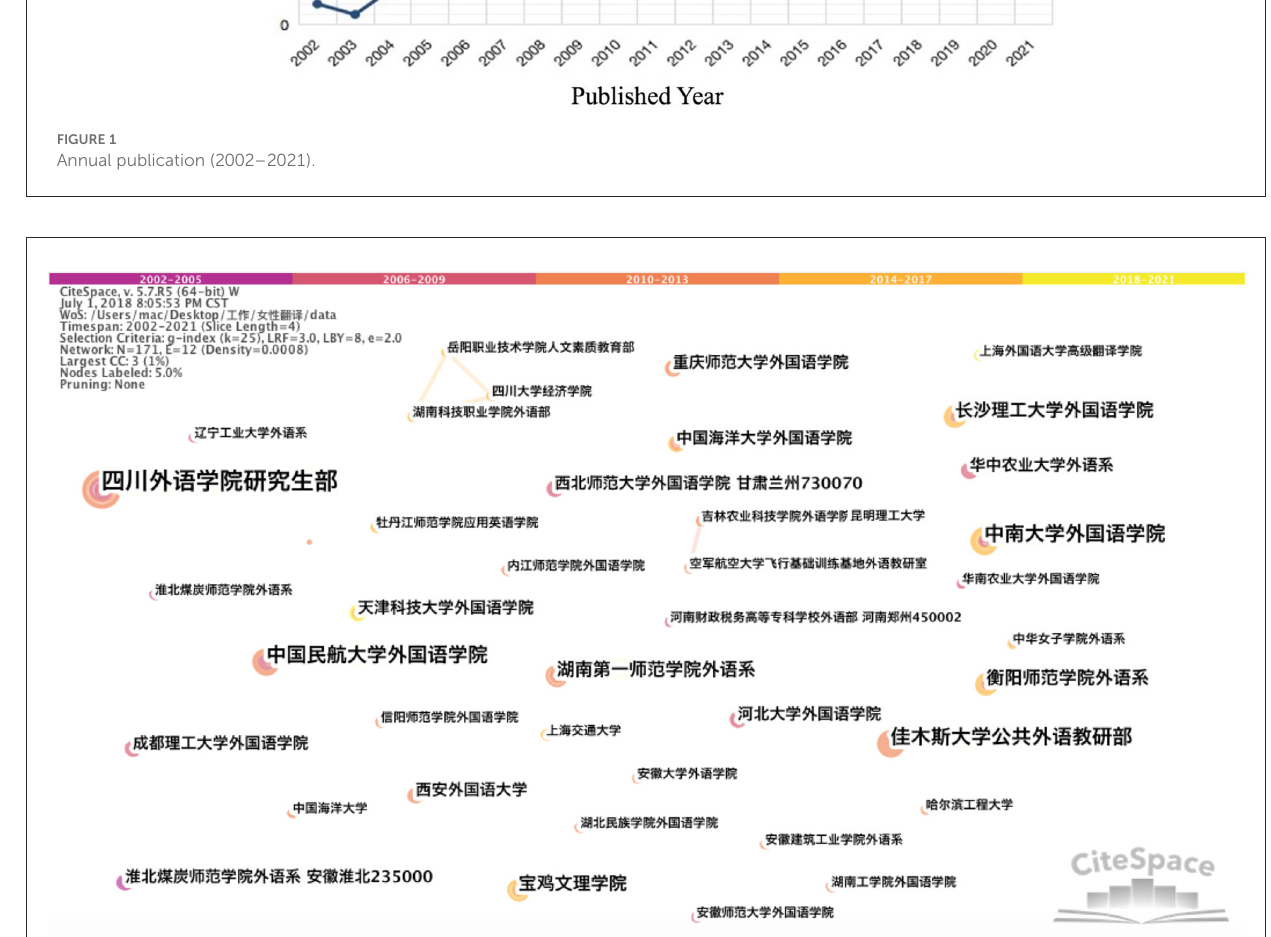
FIGURE2 Bibliometric analysis of research institutions of feminist translation research in China from 2002 to